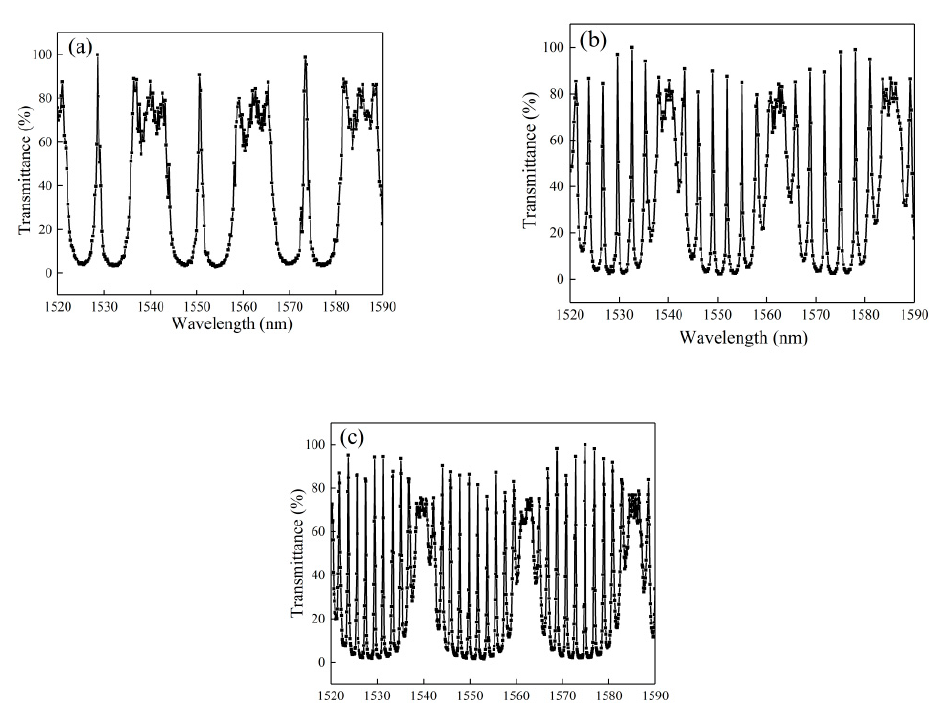
and ( c ) 584.38 µ m, Figure 4. Transmission spectrum of the F-P etalon with a gap distance of ( a ) 174.95 μ m, ( b ) 295.95 μ m, and ( c ) 584.38 μ m, respectively.